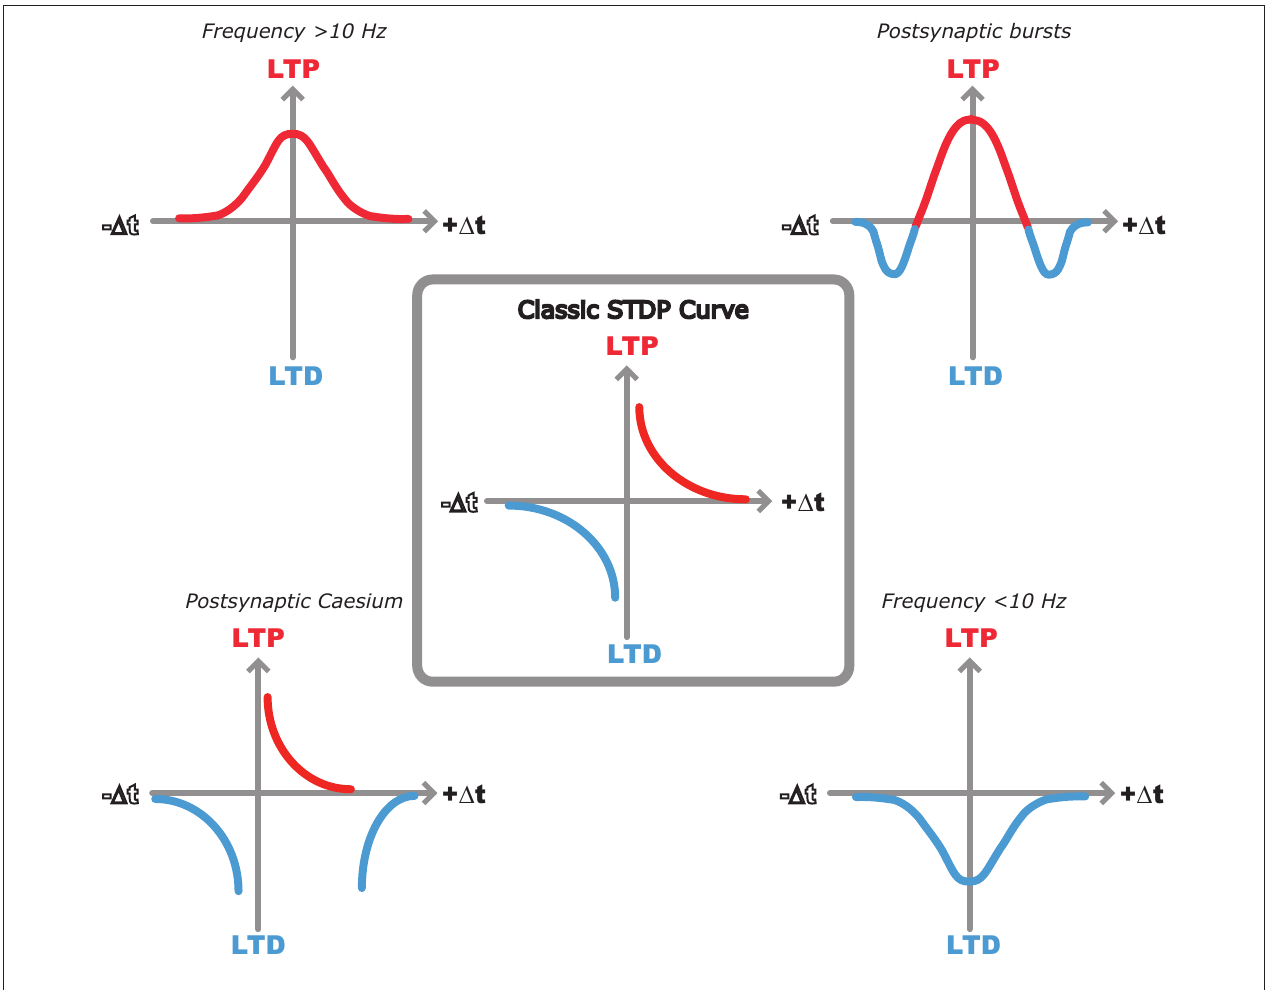
with postsynaptic bursts (Wittenberg and Wang, 2006). Bottom right, LTD only window when spike timing pairs are repeated at less than 10 Hz (Wittenberg and Wang, 2006). Bottom left, classic STDP window with additional LTD window observed with postsynaptic cesium in hippocampal slices (Nishiyama et al.,